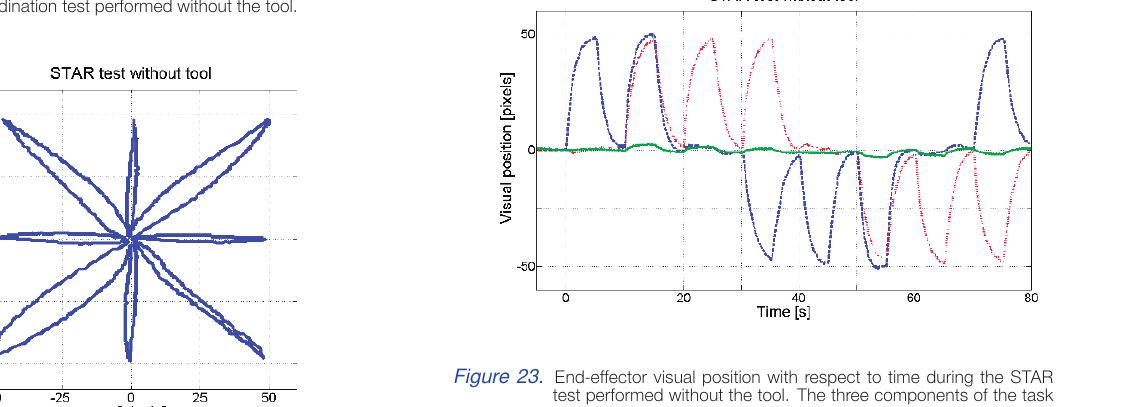
Figure 20. Arm joints positions trajectory with respect to time during the arm- head coordination test performed without the tool.